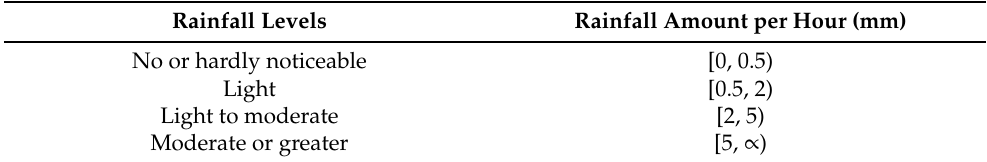
Table 2. Categories of 1-h rainfall.